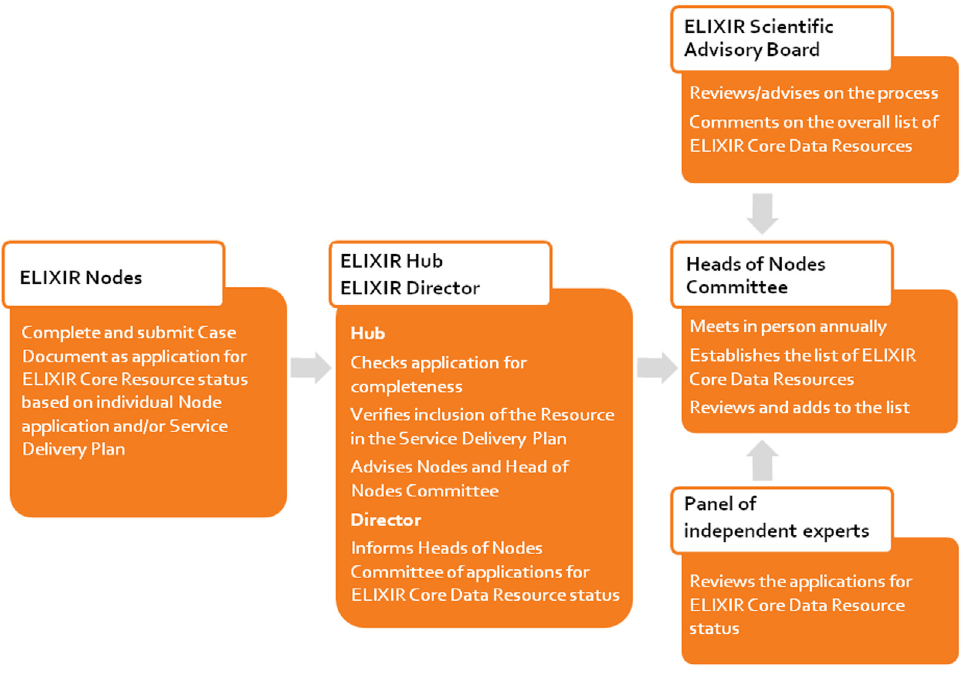
Figure 3. Process for identifying ELIXIR Core Data Resources.